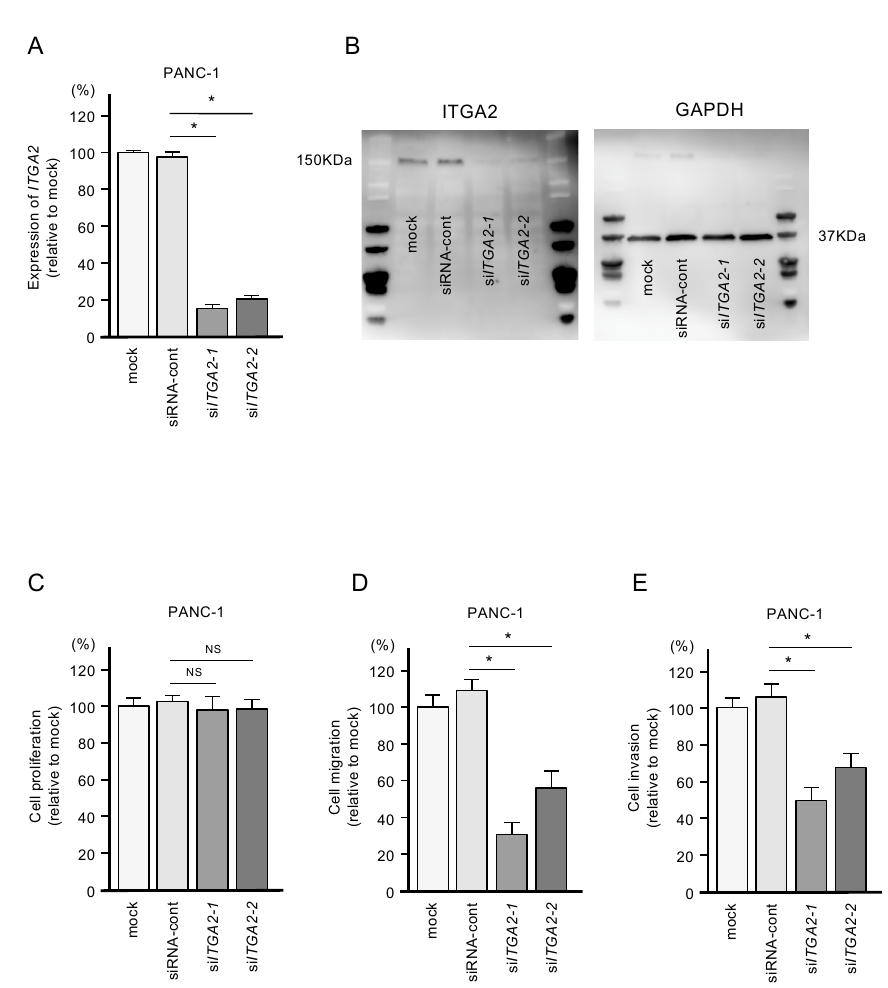
Figure 7. Effects of ITGA2 knockdown in PANC-1 cells. ( A ) mRNA and ( B ) protein expression levels of ITGA2 after transfection of two types of si ITGA2 (si ITGA2-1 and si ITGA2-2 ; 72 h after transfection). GAPDH / GAPDH was used as an internal control. ( C ) Cell proliferation using XTT assays. Data were collected at 72 h after miRNA transfection. ( D ) Cell migration with a membrane culture system. Data were collected at 48 h after seeding the cells into the chambers (* p < 0.0001). ( E ) Cell invasion using Matrigel invasion assays at 48 h after seeding miRNA-transfected cells into the chambers. (* p < 0.0001)